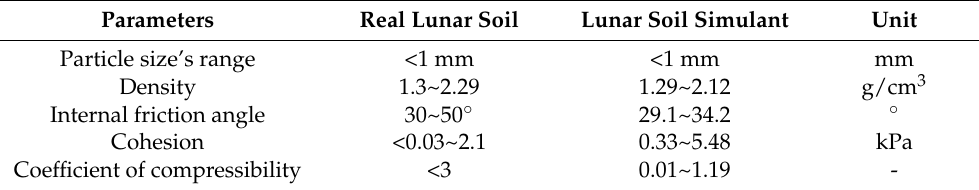
Table 4. Physical and mechanical parameter’s comparison between lunar soil simulant and real lunar soil.